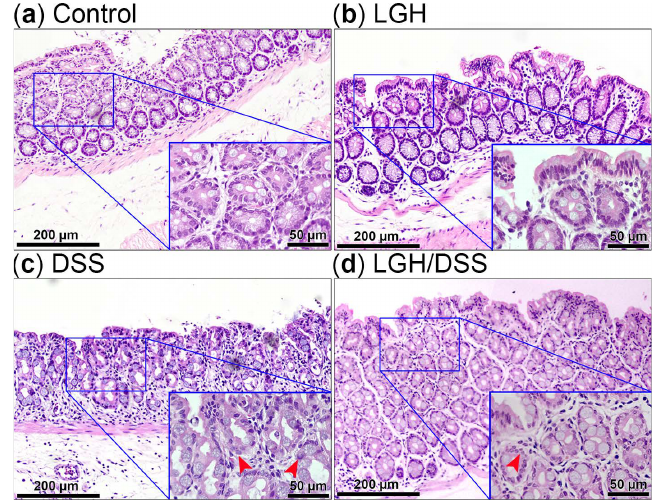
Figure 4. Representative histological staining from mouse colons of different groups. Colon tissue sections from control group ( a ), LGH group ( b ), DSS group ( c ), and LGH/DSS group ( d ) were stained with hematoxylin and eosin (H&E; scale bar, 200 µ m). Each inset represented the corresponding area of H&E staining at higher magnification (scale bar, 50 µ m). Red arrowheads representatively indicated the cells with folliculate enlargement in the DSS group and with architectural shrunken in the LGH/DSS group. DSS, dextran sodium sulfate; LGH, longish glucomannan hydrolysates. Nutrients 2022 , 14 , x FOR PEER REVIEW